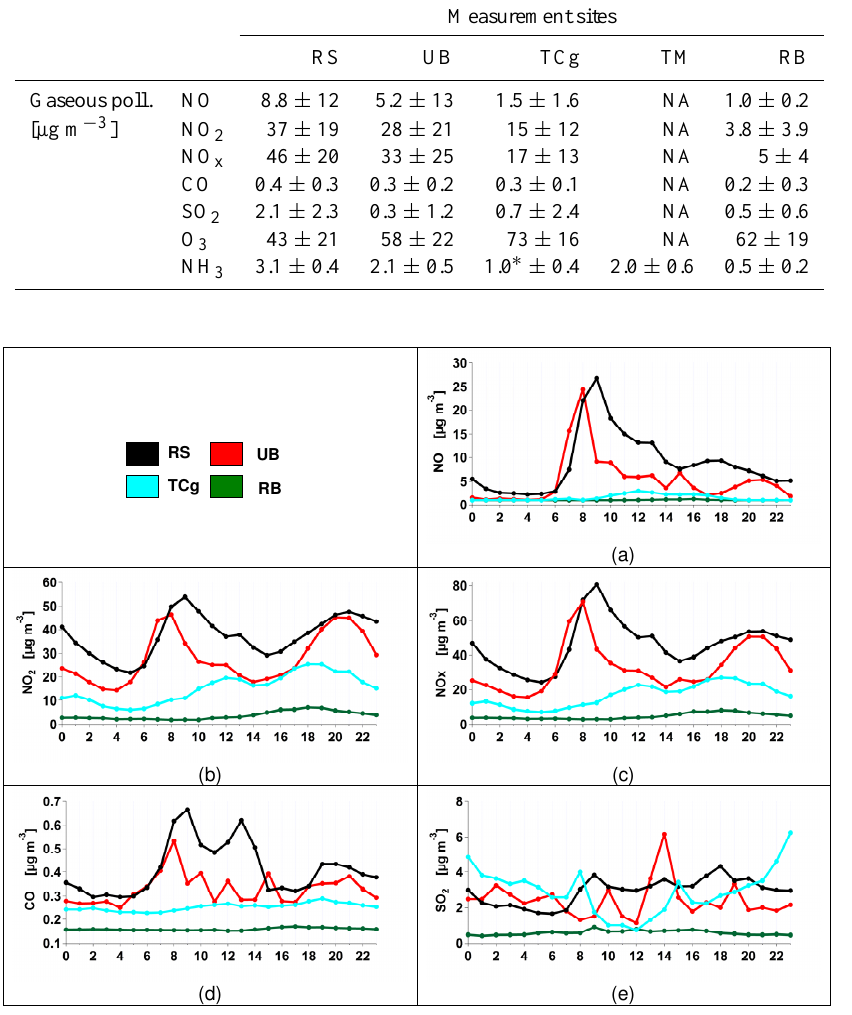
Fig. 8. Diurnal variation of gaseous measurements at five different monitoring sites: (a) NO, (b) NO 2 , (c) NO x , (d) CO, (e) SO 2 . Ozone is reported in Fig.